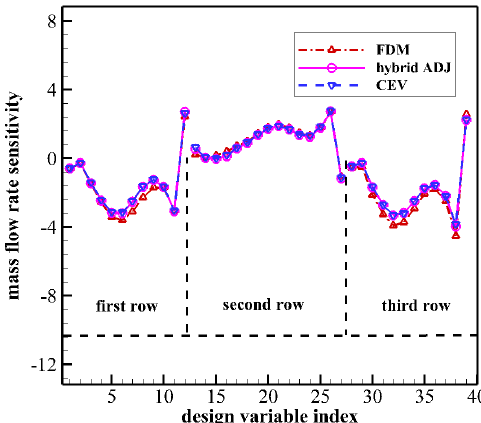
Figure 25. Verification of sensitivity accuracy for the Aachen turbine case.